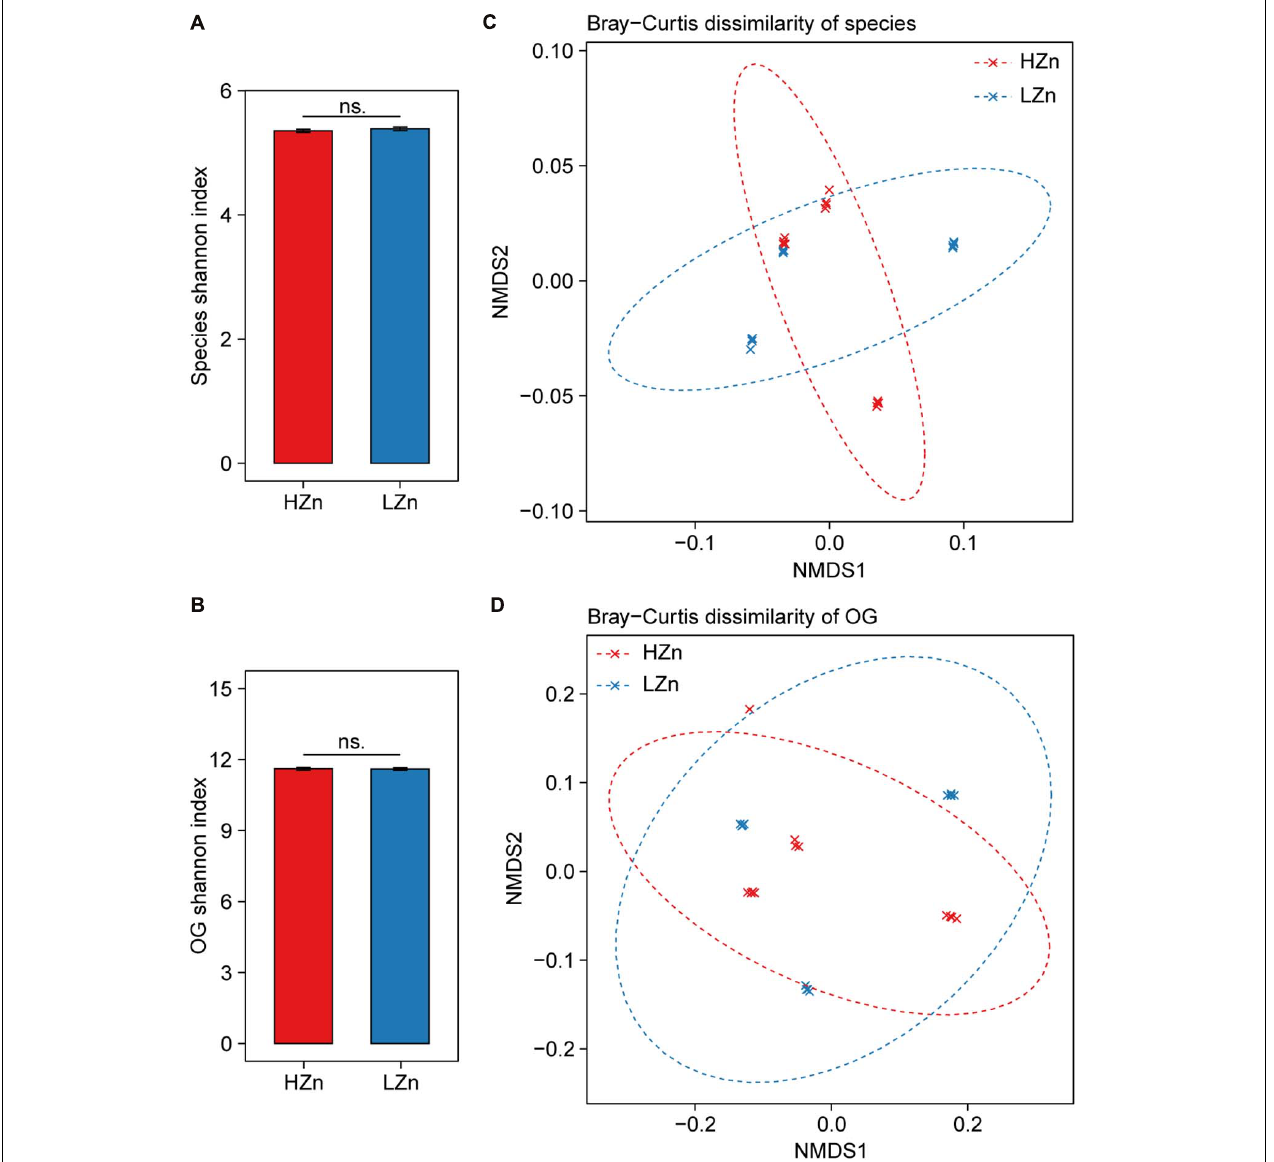
FIGURE 3 | Comparisons of rhizosphere microbiome diversity between high-Zn (HZn) and low-Zn (LZn) wheat. Within-sample alpha diversity (the Shannon–Wiener index) of rhizosphere-enriched species (A) and eggNOG Orthologous Groups (OGs) (B) between HZn and LZn. The error bars stand for mean ± standard error (HZn, n = 12; LZn, n = 12); and ns indicates no significant difference between HZn and LZn ( t -test, P < 0.05). Between-sample beta diversity of rhizosphere-enriched species (C) and OGs (D) among HZn and LZn samples are analyzed by non-metric multidimensional scaling (NMDS) of the Bray–Curtis dissimilarity. Red and blue crosses refer to HZn and LZn samples, respectively; and the corresponding ellipses cover 90% of the data